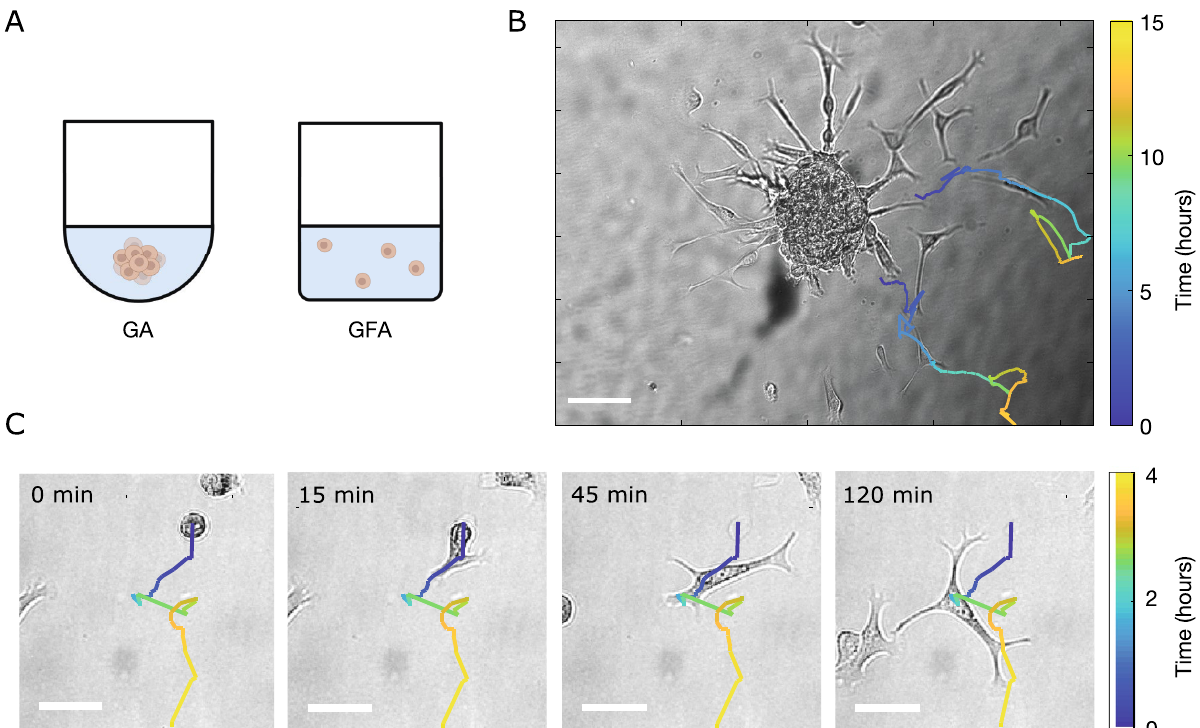
Figure 1. Brain cancer cells invading the ECM. ( A ) Schematics of an ECM-embedded spheroid in a gradient assay (GA) or individual cells in a gradient-free assay (GFA). ( B ) Tracks of migrating cells in a GA from t = 9 h and t = 5 h , respectively, superimposed on the corresponding bright field image. For each track, the color bar indicates time evolution. Scale bar is 100 µ m . ( C ) Morphological transition of a cell prior to migration. Image sequence of brain cancer cells invading the ECM at t = { 0, 15, 45, 120 } min in GFA. The track of the cell is superimposed on the bright field image. The color bar indicates time evolution and the scale bars are 50 µ m